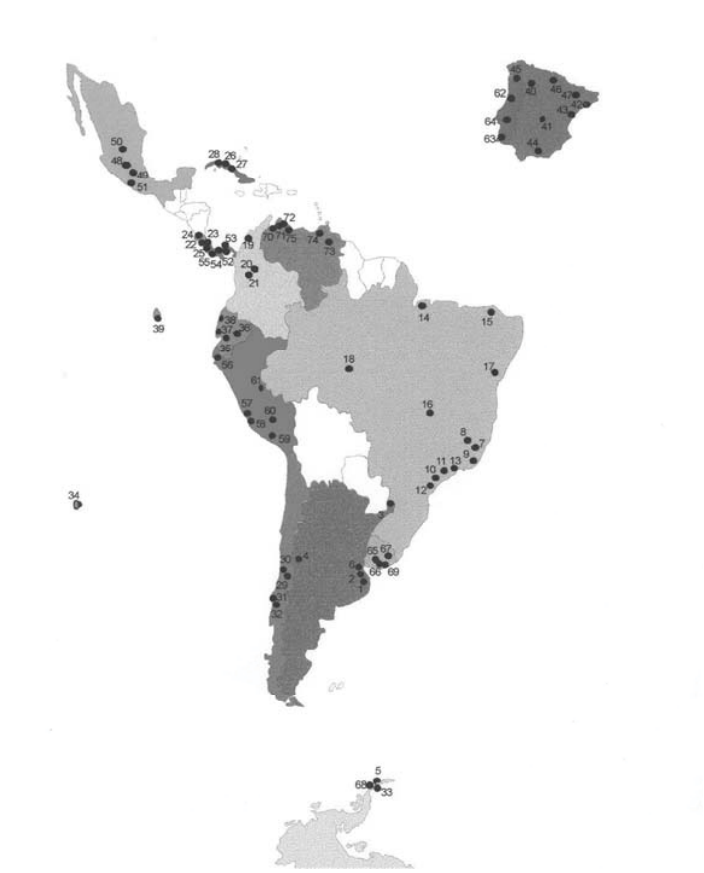
Figure 1: MICAT network of atmospheric corrosion